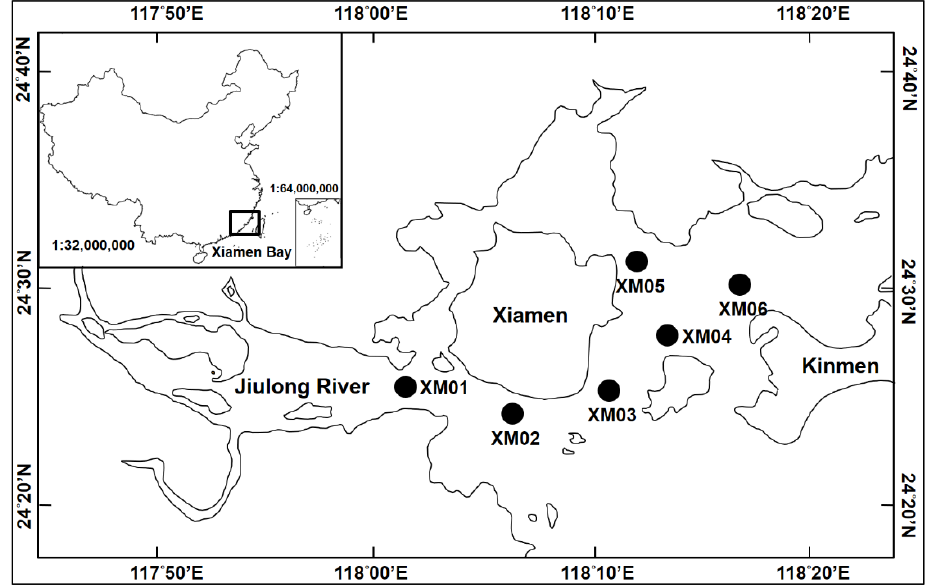
Figure 1. Map showing the location of the sample stations (XM01, XM02, XM03, XM04, XM05, and XM06) in Xiamen waters. XM06) in Xiamen